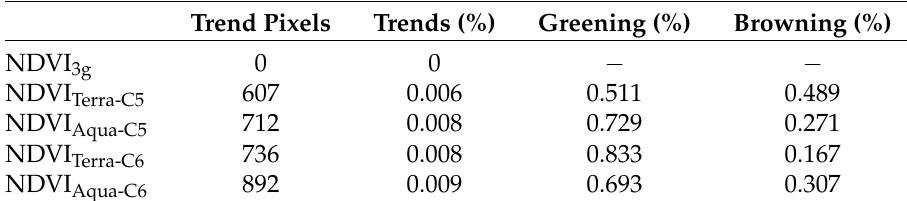
Table 3. Product-specific pixel amounts of “conclusive” monotonic trends ( p < 0.001; Figure 4). Trend